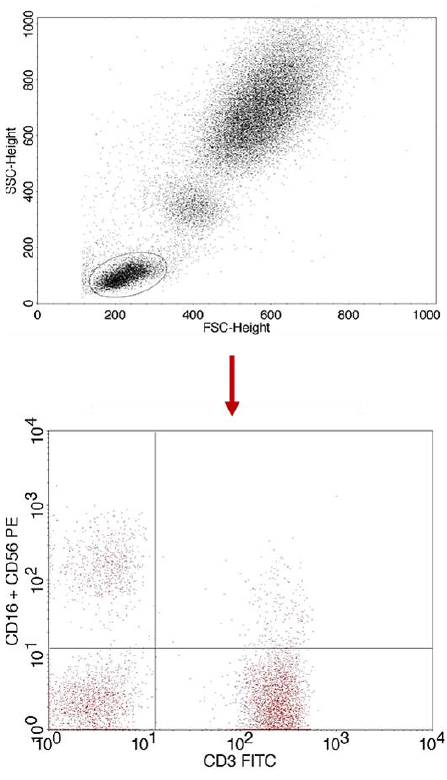
Figure 10. Sample analysis of the percentage of lymphocytes with the CD3+CD25+ and CD19+CD25+ phenotype.